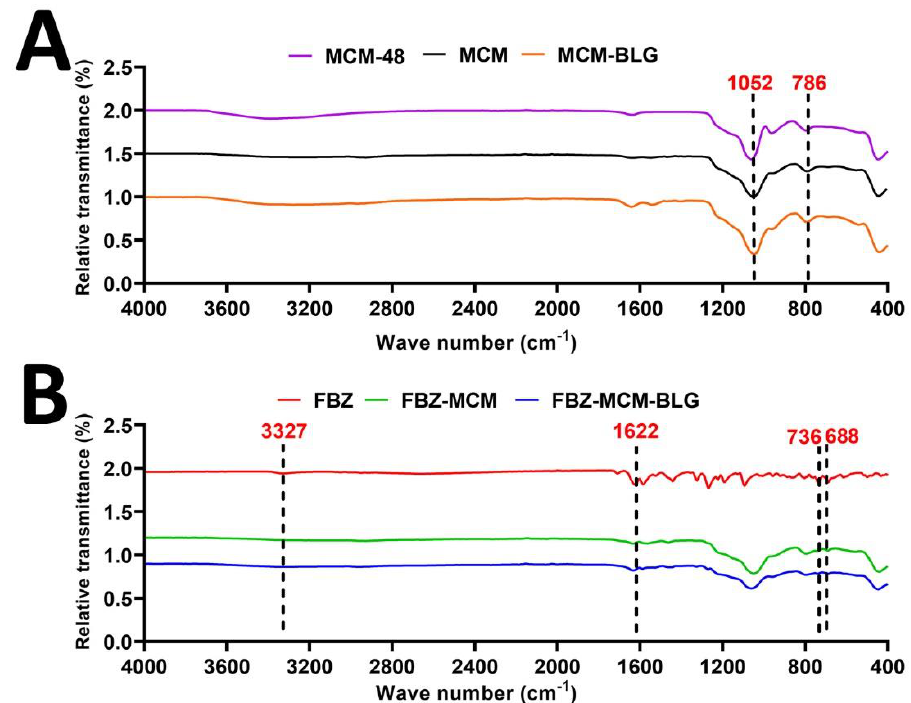
Figure 4. Fourier transform infrared spectroscopy (FTIR) spectra of ( A ) MCM-48, MCM, and MCM- BLG; and ( B ) FBZ, FBZ-MCM, and FBZ-MCM-BLG nanoparticles. The peaks at 1622, 736, and 688 cm −1 regions in the spectra of FBZ, FBZ-MCM, and FBZ-MCM-BLG nanoparticles prove that (i) FBZ meaning that FBZ was physically loaded into these NPs.